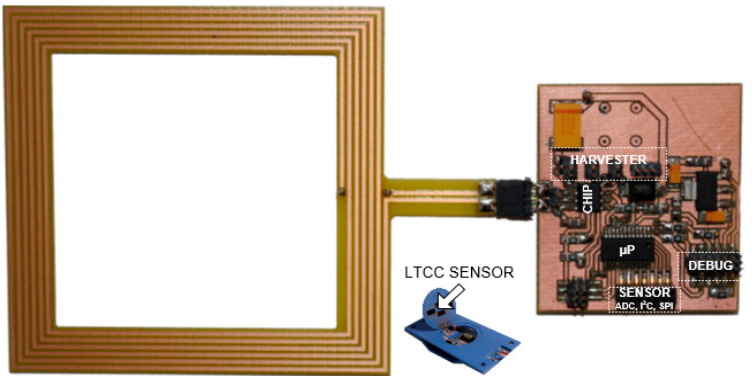
Figure 5. Practical implementation of semi-autonomous RFID sensor operating in the HF band, with LTCC pressure transducer.